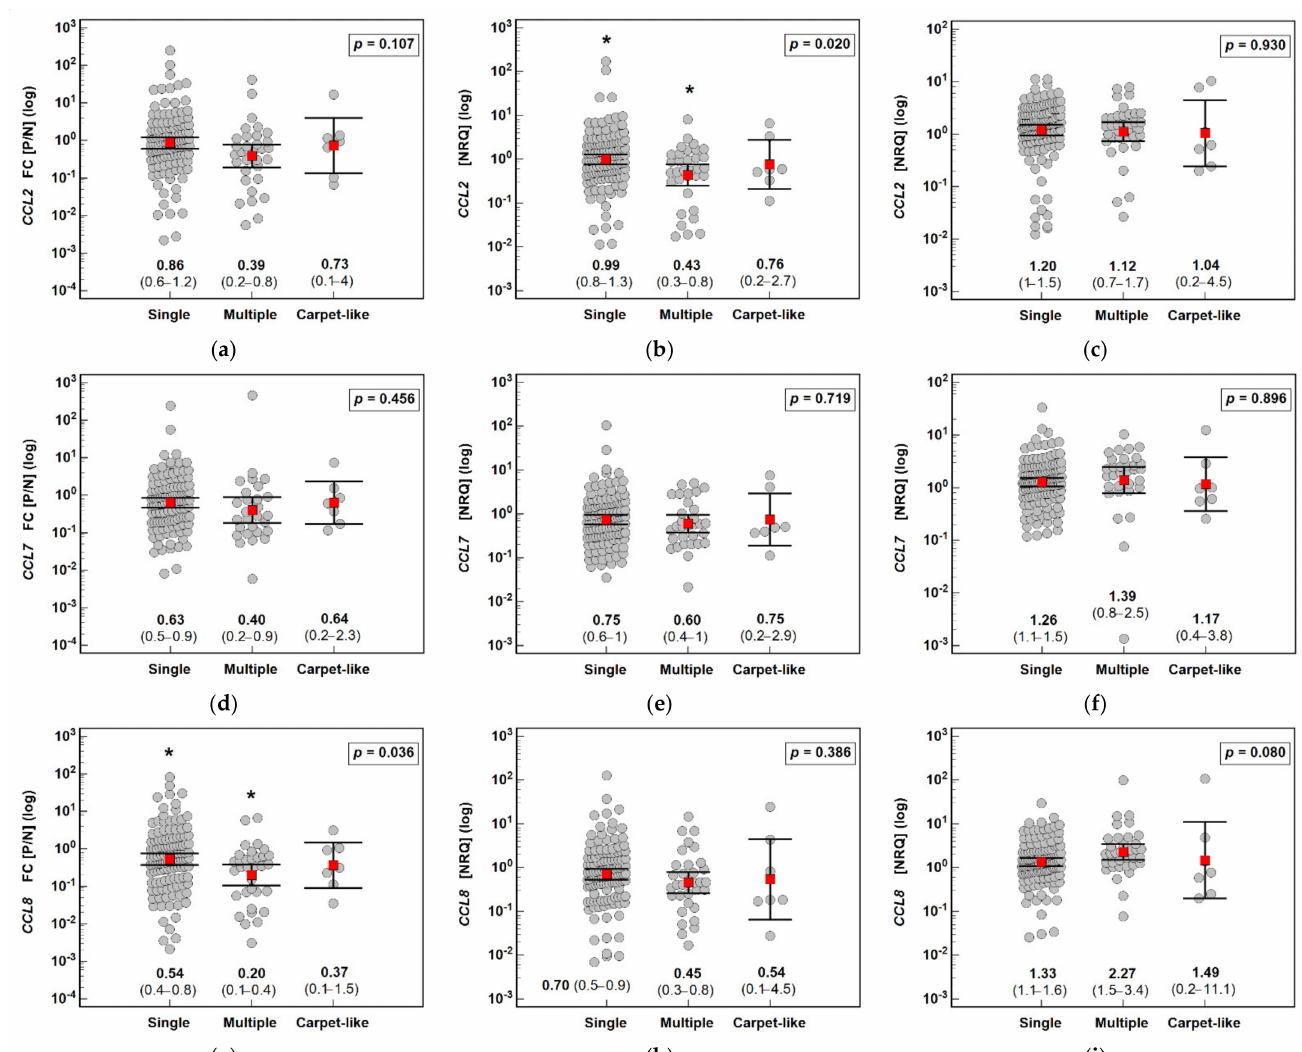
Figure 7. Effect of the number of polyps on the expression (mRNA) of MCP chemokines in patients with colorectal polyps: ( a ) fold change (FC) in CCL2 expression between the polyp and normal mucosa (P/N); ( b ) CCL2 expression in a polyp; ( c ) CCL2 expression in normal tissue; ( d ) fold change (FC) in CCL7 expression between the polyp and normal mucosa (P/N); ( e ) CCL7 expression in a polyp; ( f ) CCL7 expression in normal tissue; ( g ) fold change (FC) in CCL8 expression between the polyp and normal mucosa (P/N); ( h ) CCL8 expression in a polyp; ( i ) CCL8 expression in normal tissue. Data analyzed as logarithms using one-way ANOVA with a Student–Newman–Keuls post hoc test and presented as means with 95% confidence intervals (red squares with whiskers and numbers below dot plots). Significant ( p < 0.05) differences between groups (identified in post hoc analysis) are indicated by an asterisk (*). NRQ: normalized relative